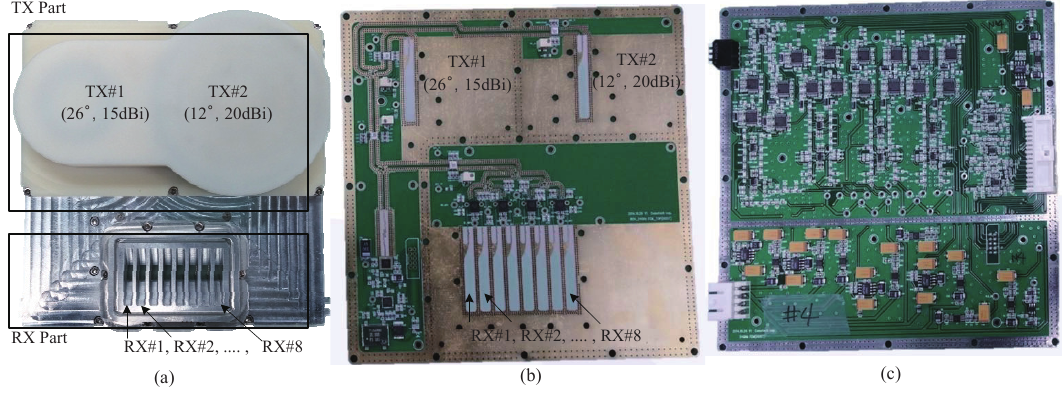
Figure 13. Images of 24 GHz 2 × 8 RF module (front-end module) ( a ) outside; ( b ) top-view; ( c )